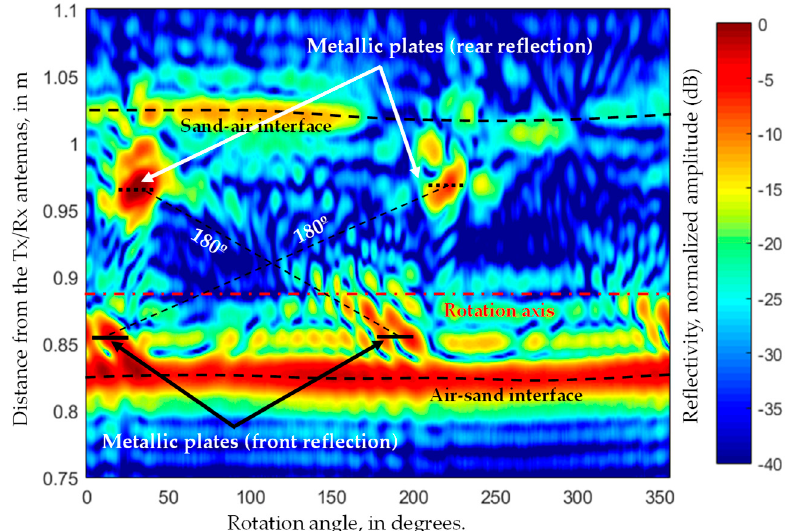
Figure 10. Reflectivity calculated for each observation angle as a function of the distance from the Tx/Rx antennas, for a XY slice (z 1 = − 13 cm with respect to the top of the plastic box). Air-sand (front reflection) and sand-air (rear reflection) interfaces are noticed, as well as the stronger reflection in the metallic plates.